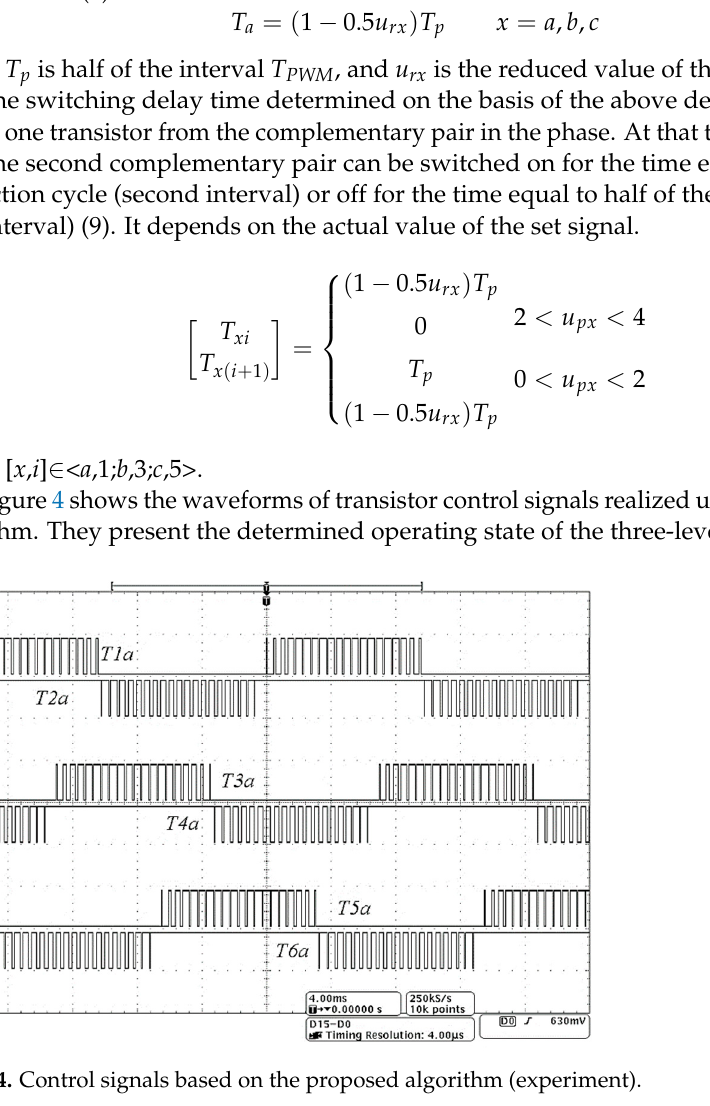
Figure 4. Control signals based on the proposed algorithm